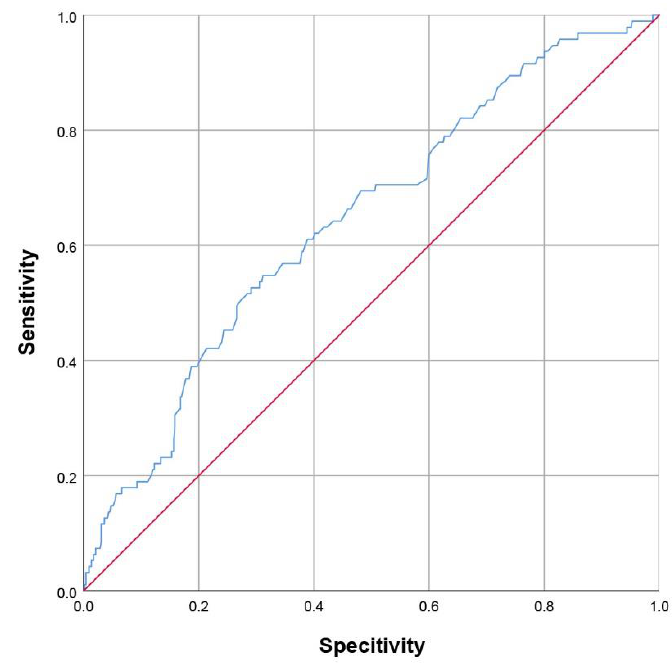
Figure 2. Receiver operating characteristic (ROC) curve analysis for the plasma level of fibrinogen on admission in predicting Post-stroke depression at discharge.